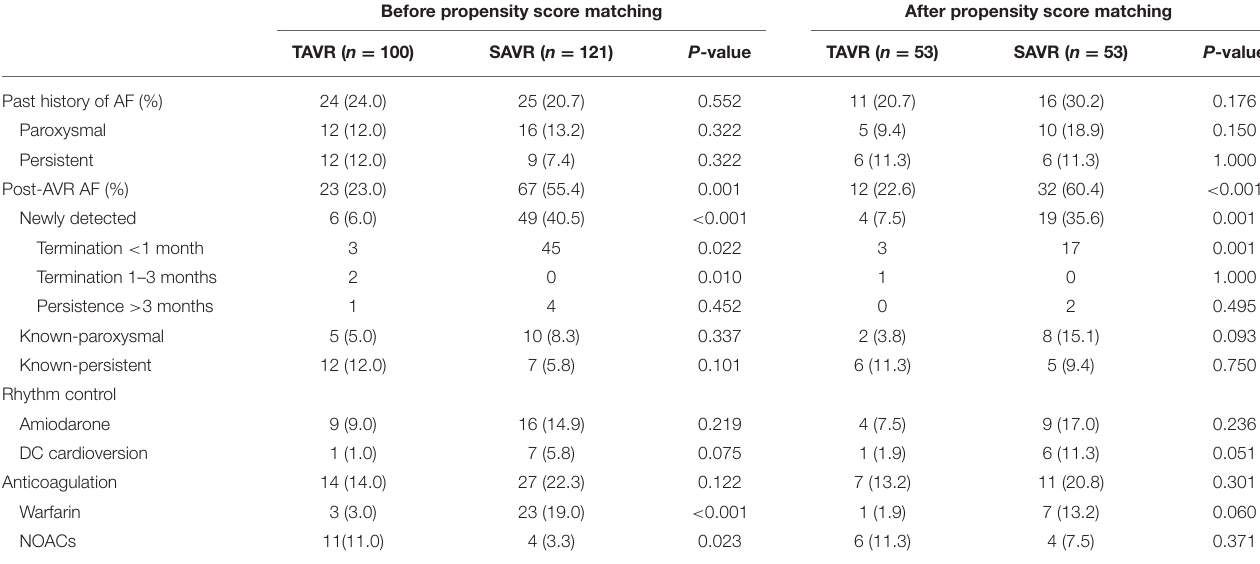
TABLE 2 | Atrial fibrillation occurrence before and after procedure. Before propensity score matching After propensity score matching